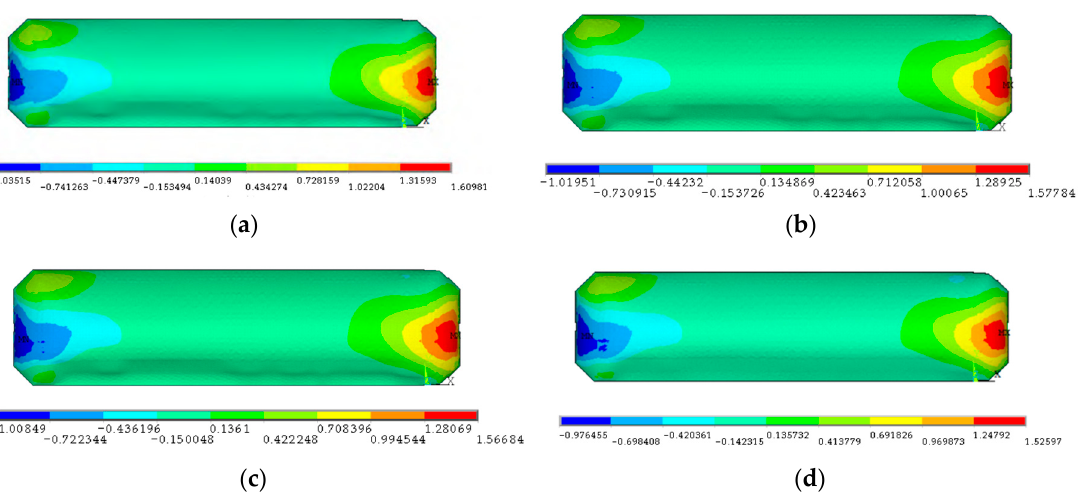
Figure 8. Cloud chart of x -component membrane surface displacement (unit: m): ( a ) μ = 0.2; ( b ) μ = 0.44; ( c ) μ = 0.68; and ( d ) μ = ∞ *.